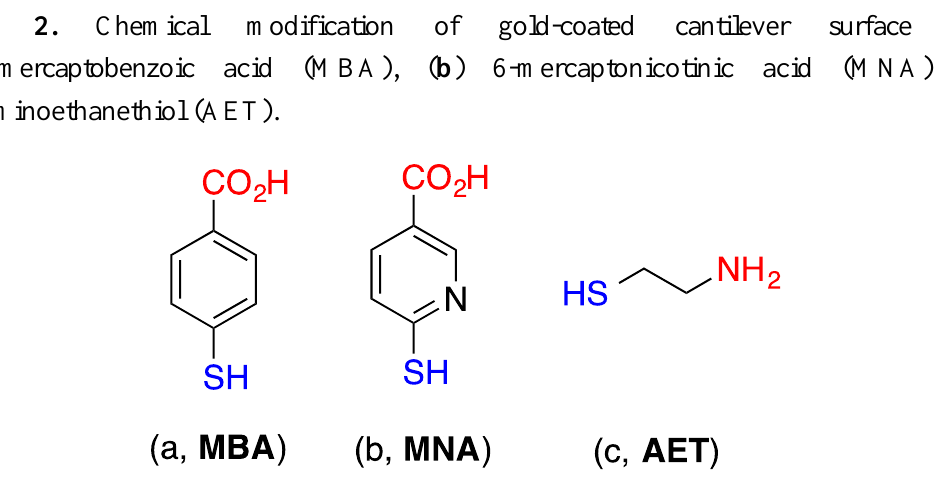
Figure 3. The representative X-Ray Photoelectron Spectroscopy (XPS) spectra analysis of the surfaces of the cantilevers modified with 4-mercaptobenzoic acid